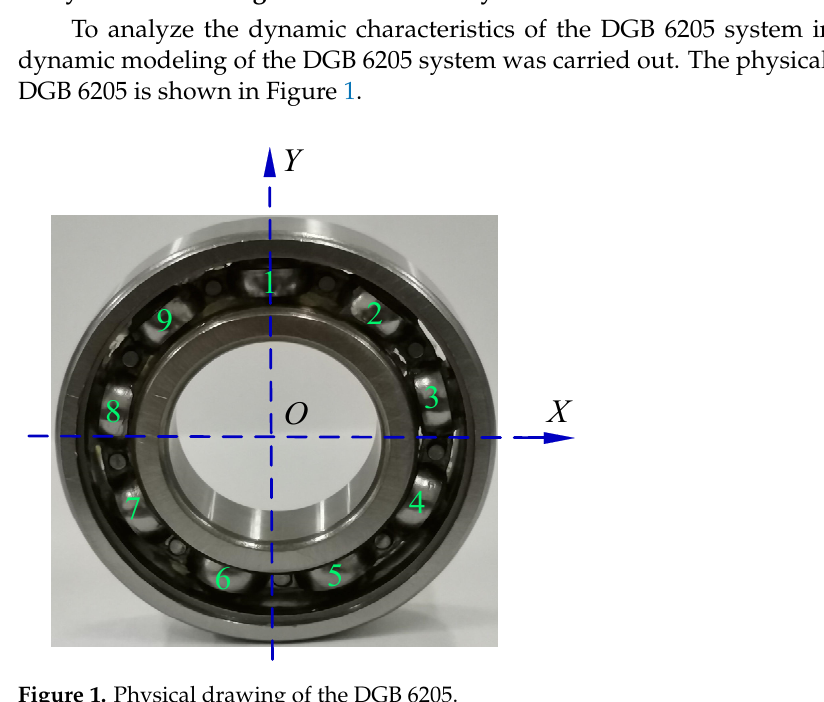
Figure 1. Physical drawing of the DGB 6205. In Figure 1, the DGB 6205 has 9 rolling elements, and the numbers 1–9 represent the roller number respectively. The center of the bearing inner race is taken as the